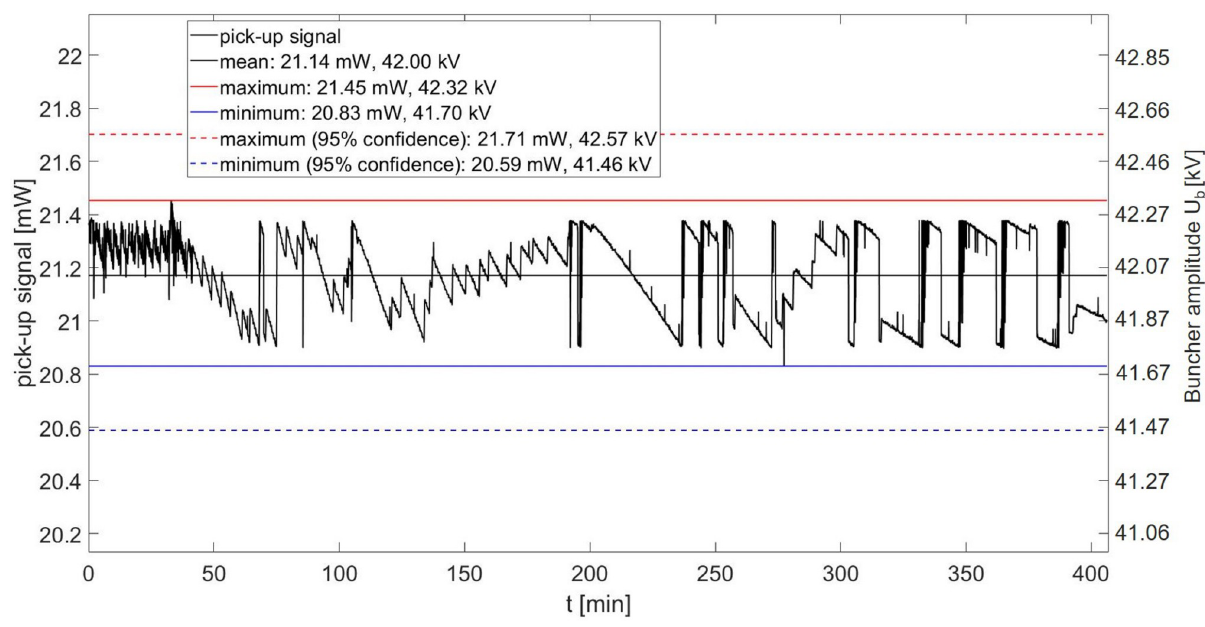
Fig 14. Pick-up signal measurement of the 4-gap concept with 800W (8 μ s at 200 Hz) input power. Black line: Mean of the pick-up signal, red line: maximum pick-up signal and blue line minimum pick-up signal. Dashed lines: 95% coefficient interval of maximum and minimum pick-up signal.